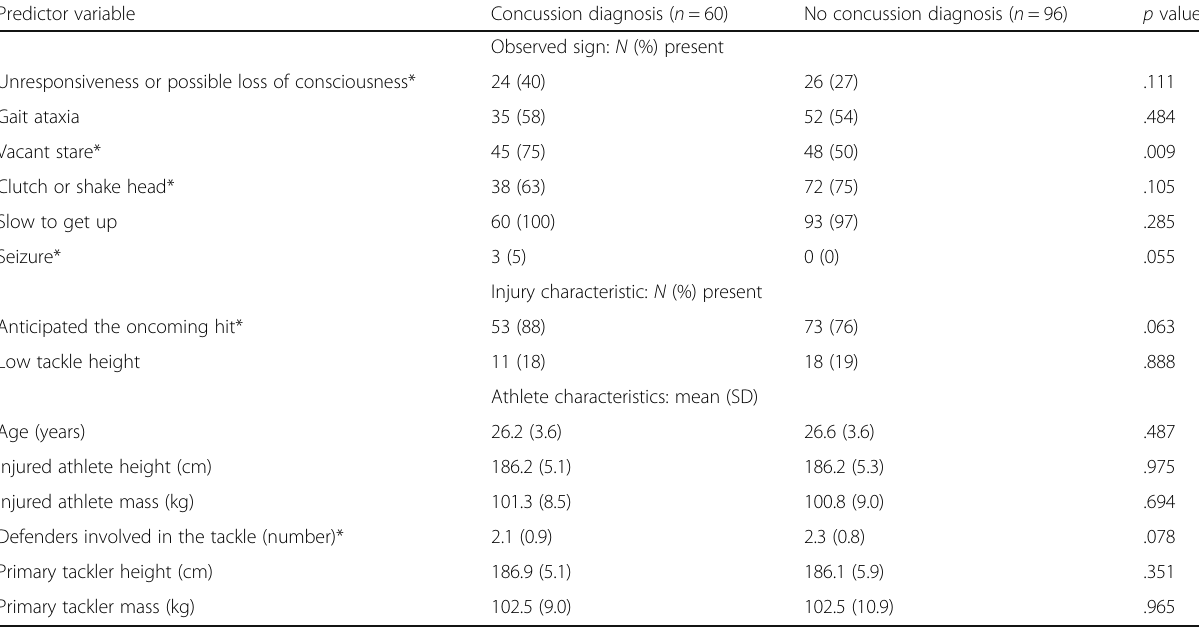
Table 4 Comparisons of potential predictor variables for those who did and did not receive a diagnosis of concussion following the use of the